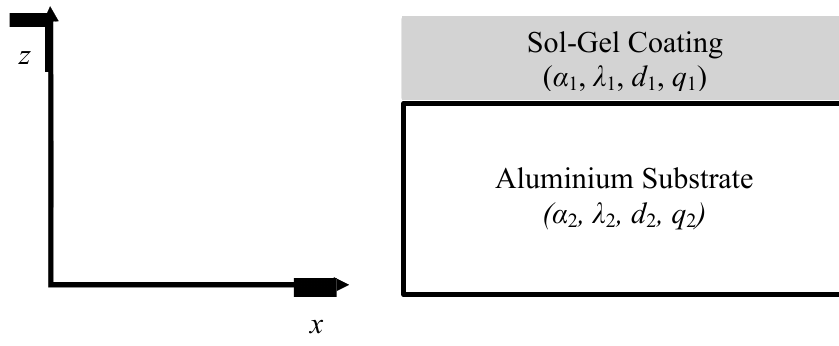
Figure 5. Schematic of the sample geometry for BDS investigation.